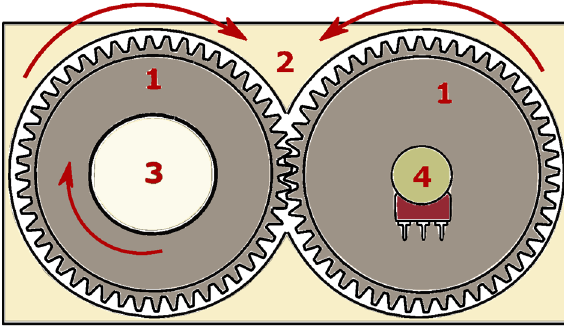
Figure 4. The structure of the encoder.